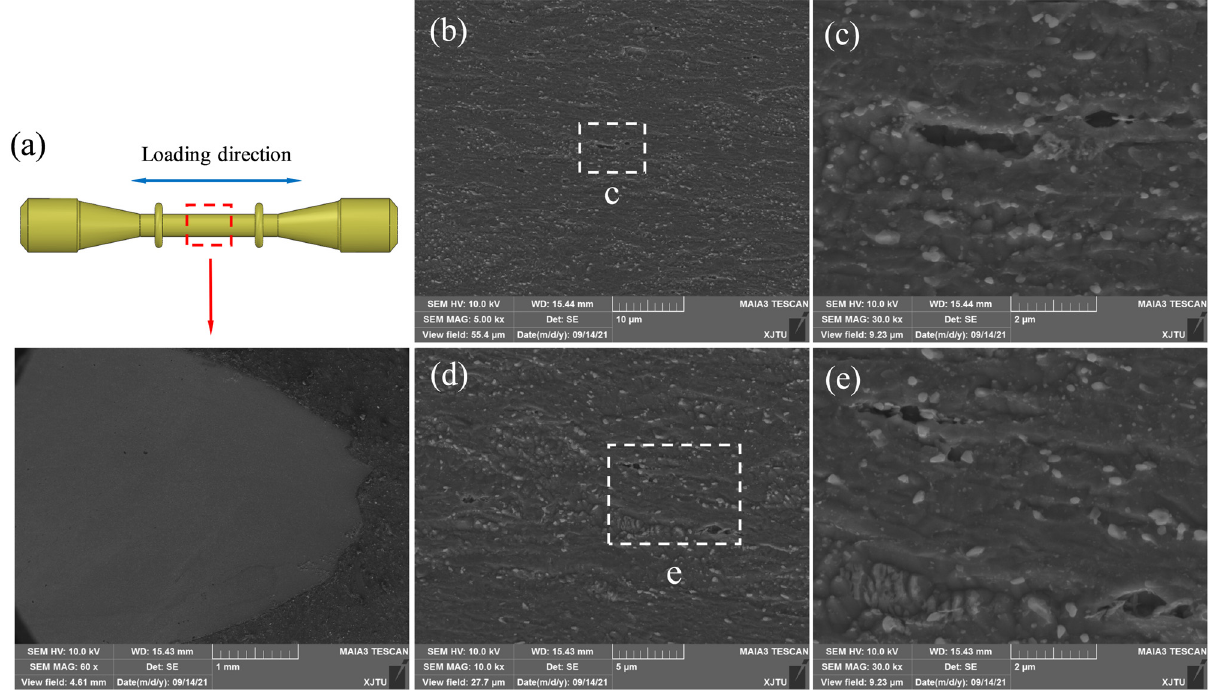
Figure 14: SEM images showing the damage zones of the creep ruptured BM specimen under the stress of 275 MPa. ( a ) The entire image of the longitudinal cross - section; ( b ) and ( d ) are the distribution of creep cavities in the BM; ( c ) and ( e ) are the morphologies of corresponding creep cavities in ( b ) and ( d ) , respectively.